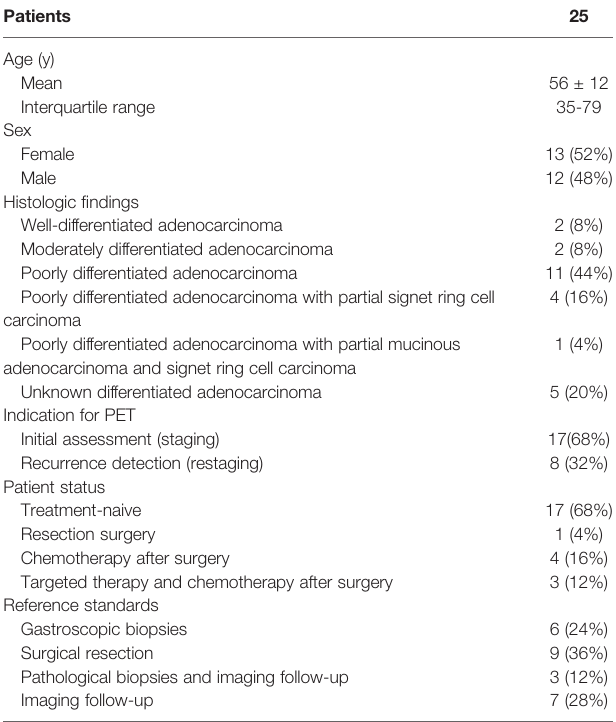
TABLE 1 | Patient